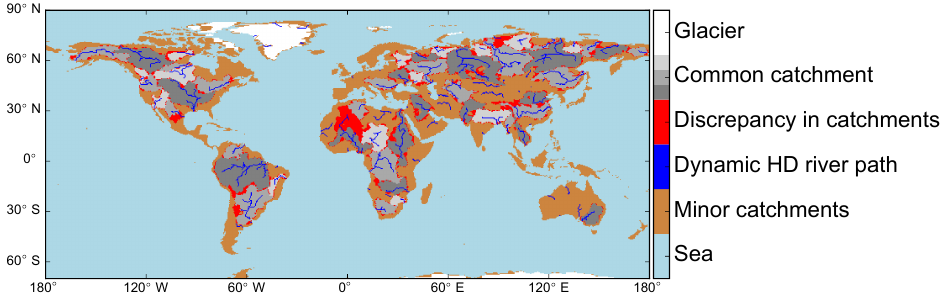
Figure 6. Comparison of the most significant present-day river catchments derived using the method presented here (“dynamic HD”) to the manually corrected HD model river directions. Discrepancies are shown in red; areas of catchments that are common between both models are marked in grey. The three different shades of grey are used to pick out individual river catchments; no significance is attached to the shade chosen for each river. Dynamic HD river paths (defined as cells with a cumulative flow of 100 cells or more) are marked to aid